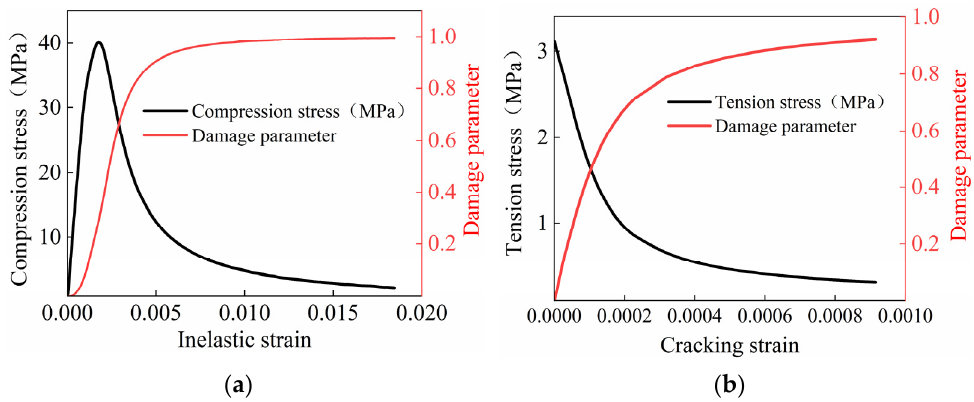
Figure 9. Concrete constitutive relation [58]. ( a ) Compressed constitutive; ( b ) stretch constitutive. Table 2. Material properties of the concrete [58].